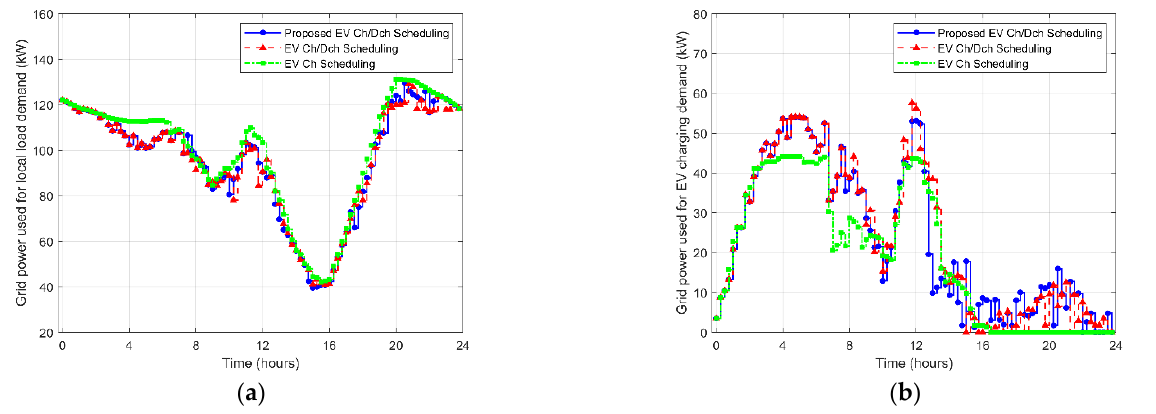
Figure 9. ( a ) The grid power consumption for local load demand; ( b ) The grid power consumption for charging demand of EVs.